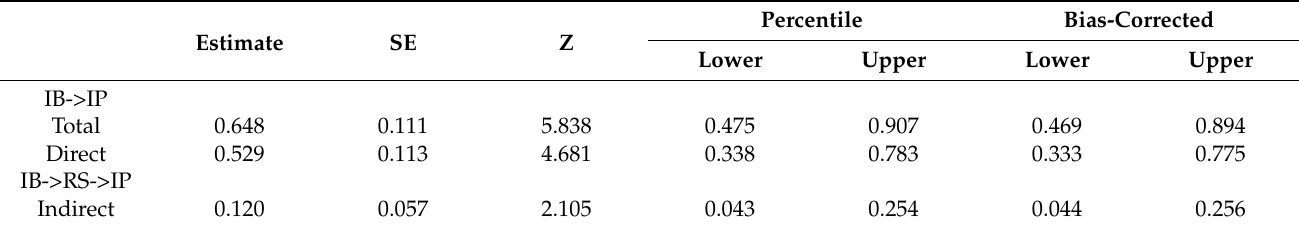
Table 5. Results of the mediating effect.